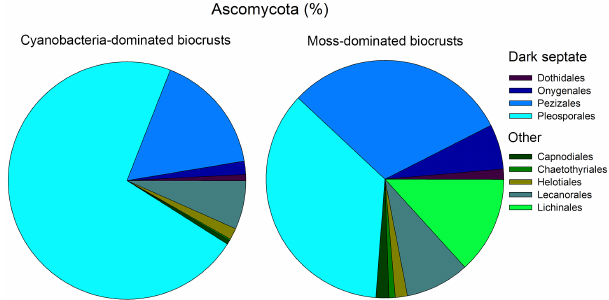
Figure 3. Pleosporales was the dominant Ascomycota order and contained dark septate species. Pie chart values are means ( n = 6) of the percent relative recovery from nine fungal orders, four of which contain dark septate endophytic taxa. Recovery was based on OTUs from eukaryotic community libraries of the 18S rRNA gene (97% similarity